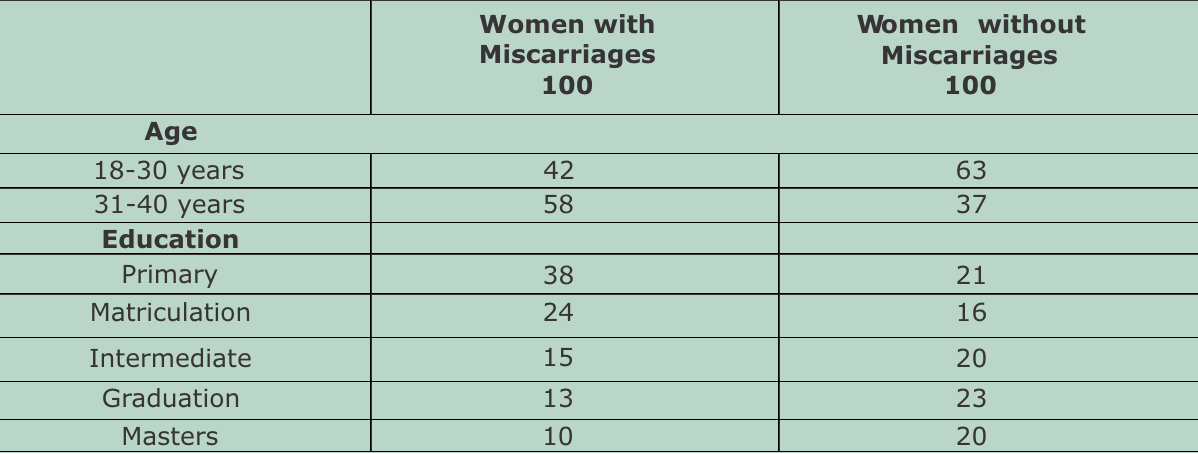
Table-I: Demographic information of the